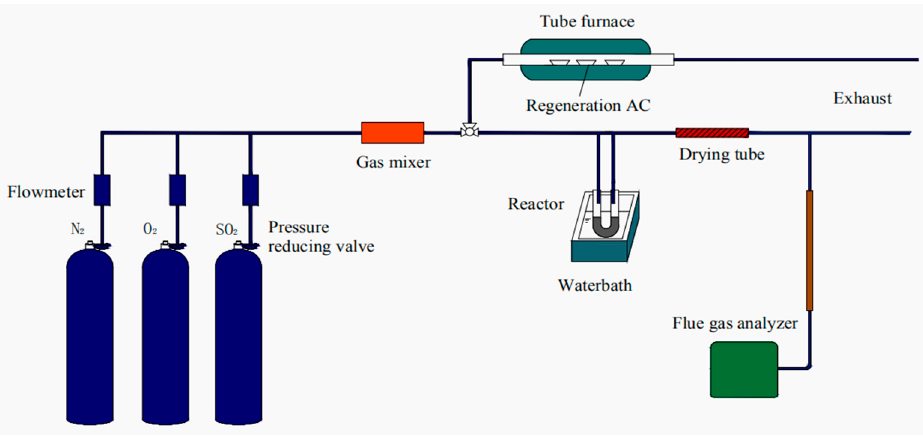
Figure 1. Schematic of the experimental apparatus. Table 1. Experimental conditions of SO 2 adsorption.